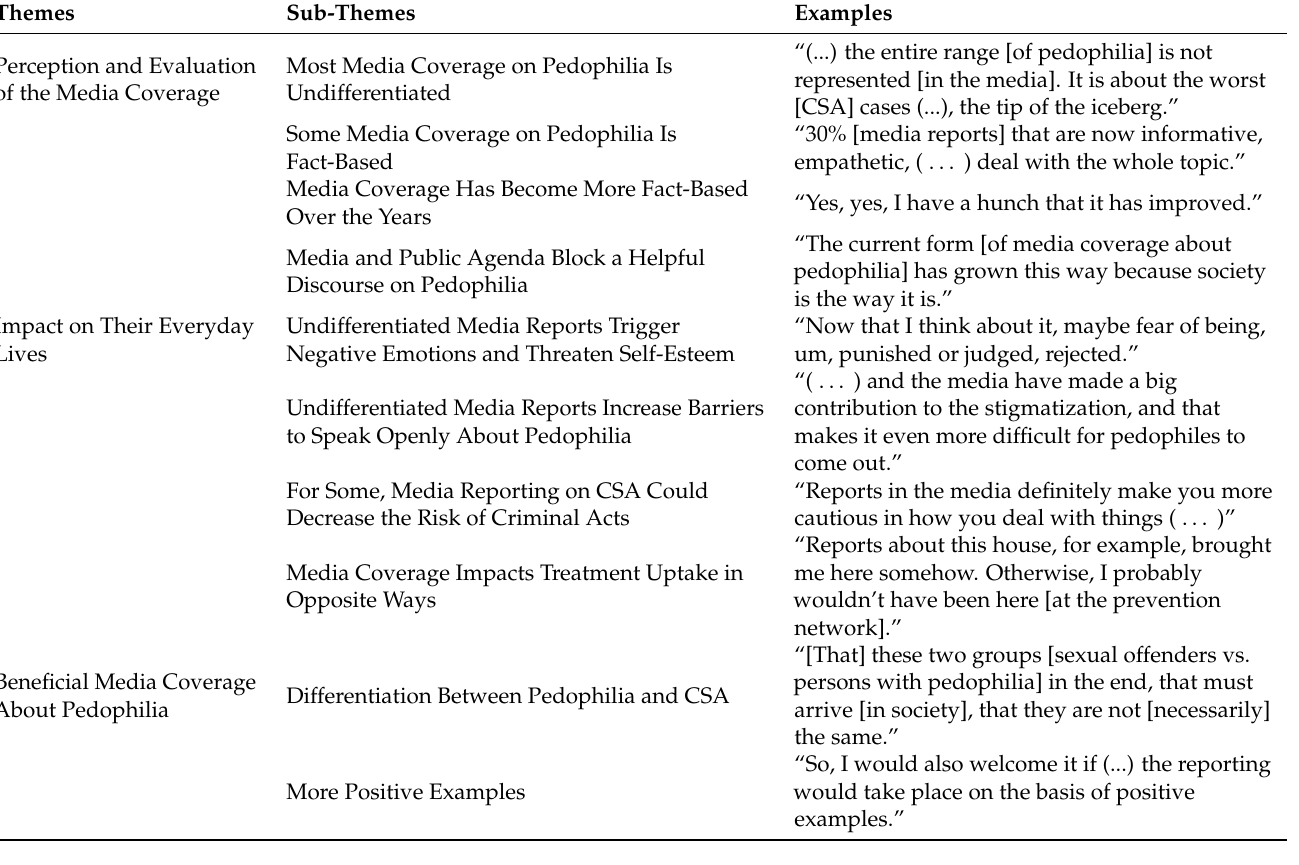
Table 1. Identified themes and